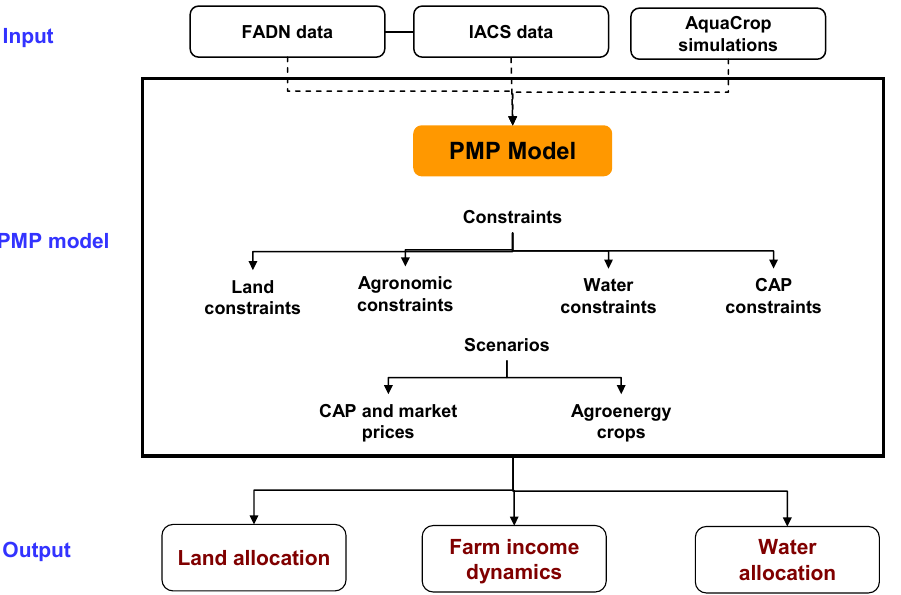
Figure 1. PMP model